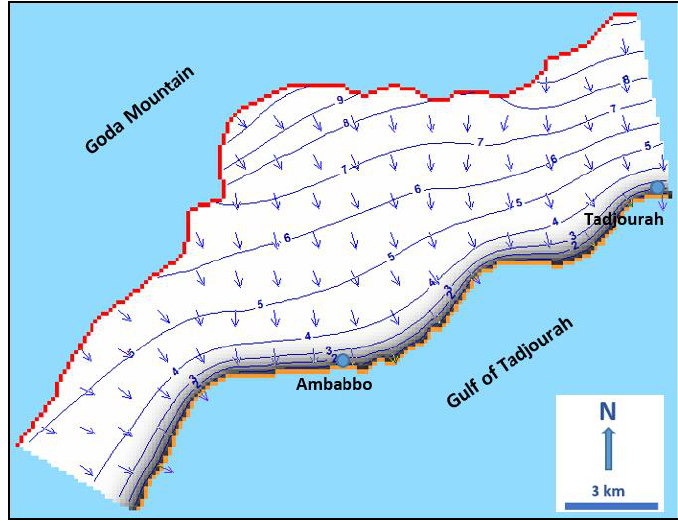
Figure 10. Simulated piezometry corresponding to the equilibrium state of the seawater intrusion.